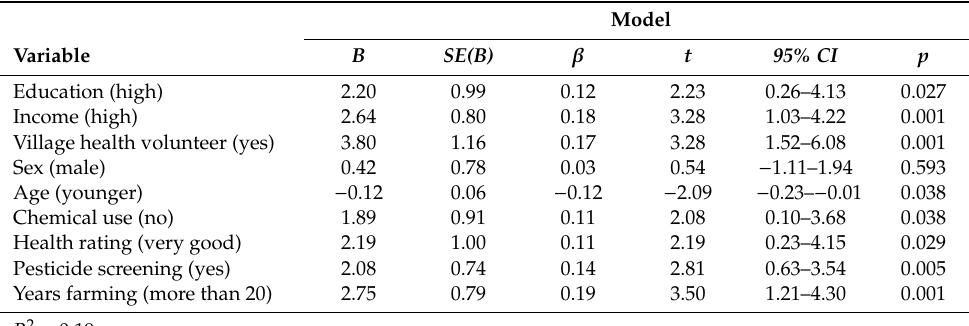
Table 3. Multiple Linear Regression Correlating Predictors with Health Literacy ( N =